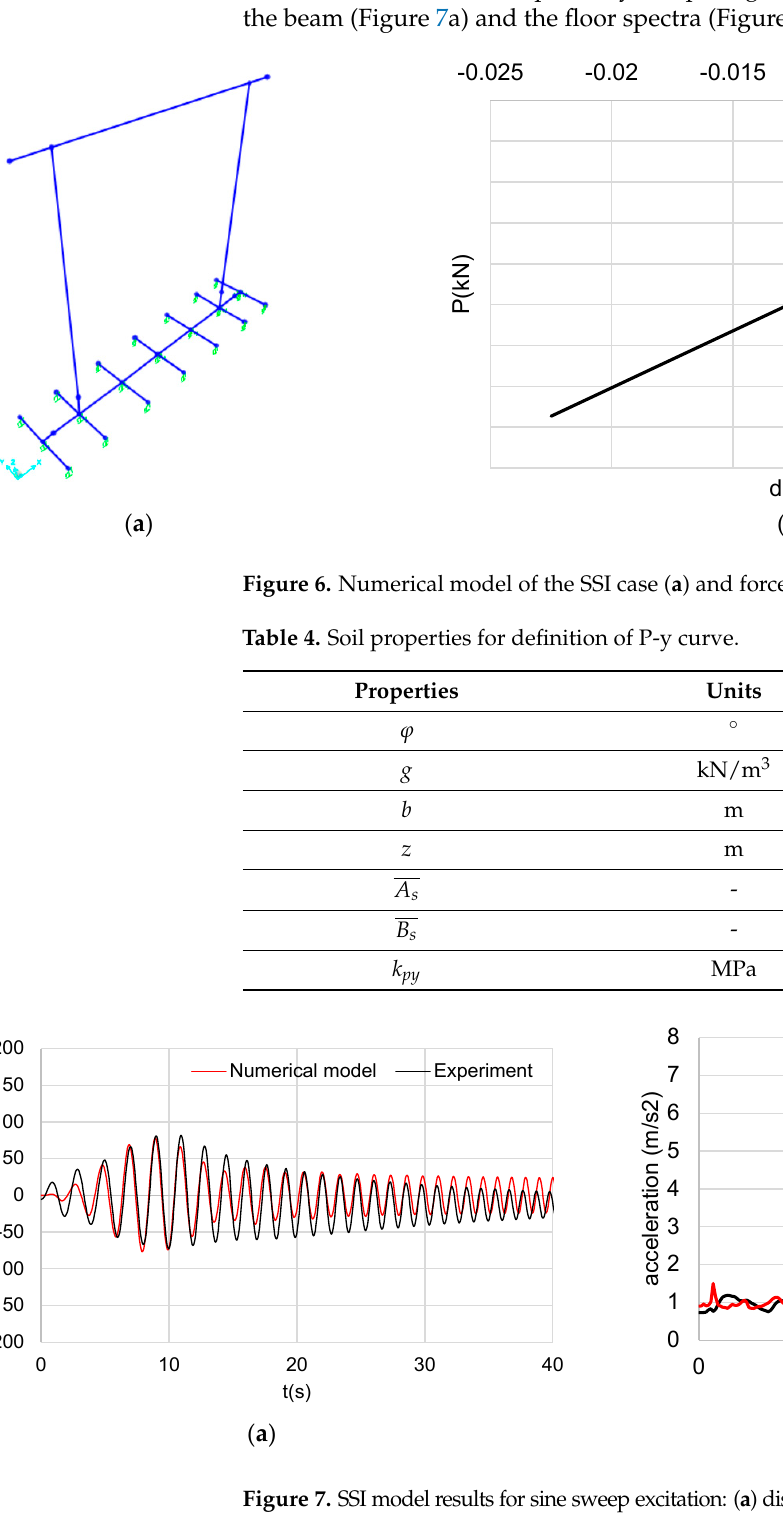
Table 4. Soil properties for definition of P-y curve.